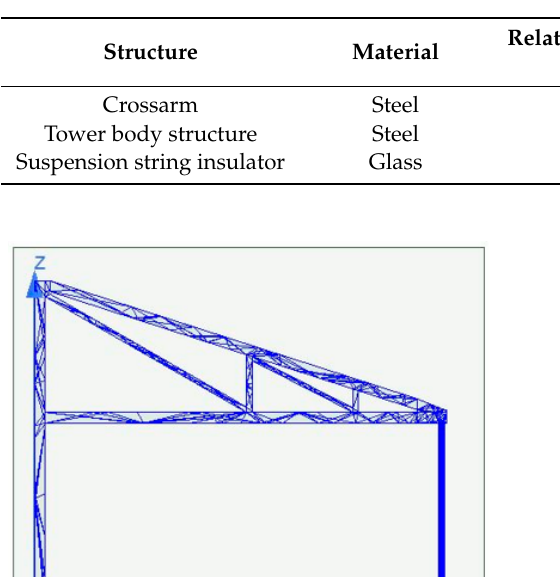
Table 8. Proposed model material properties.